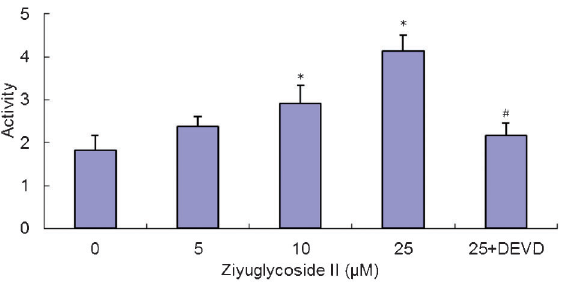
Figure 6. Activity of caspase-3 in ziyuglycoside II-induced BGC- 823 cell apoptosis. Cells were treated with the indicated drugs for 12 h. DEVD: caspase-3 inhibitor (z-DEVD-fmk: z-Asp-Glu-Val- Asp-fluoromethylketone). After incubation, caspase-3 activity was determined by fluorimetric assay. Data are reported as means±SD for n=3 independent assays. *P , 0.05 vs control, # P , 0.05 vs ziyuglycoside II-treated (Student t -test).